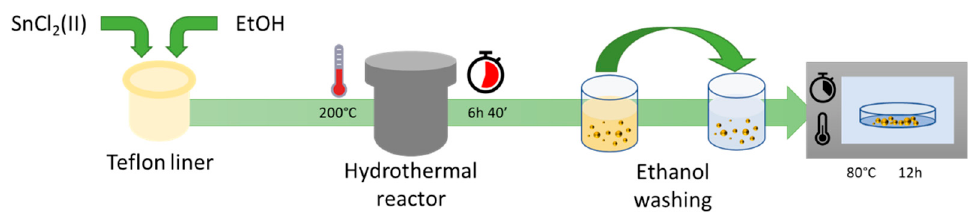
Figure 1. Synthesis procedure of SnO 2 metal oxide.